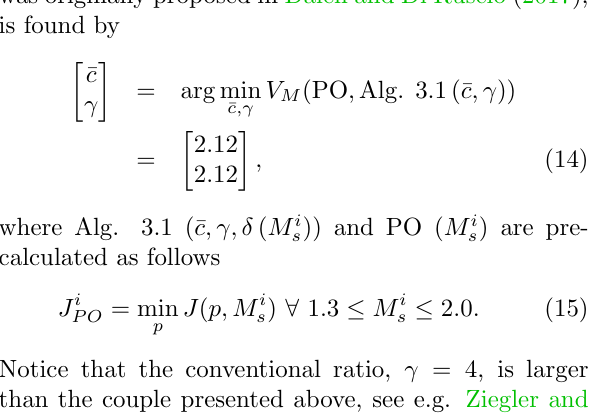
Algorithm 4.1 ( δ -PRC PID Controller